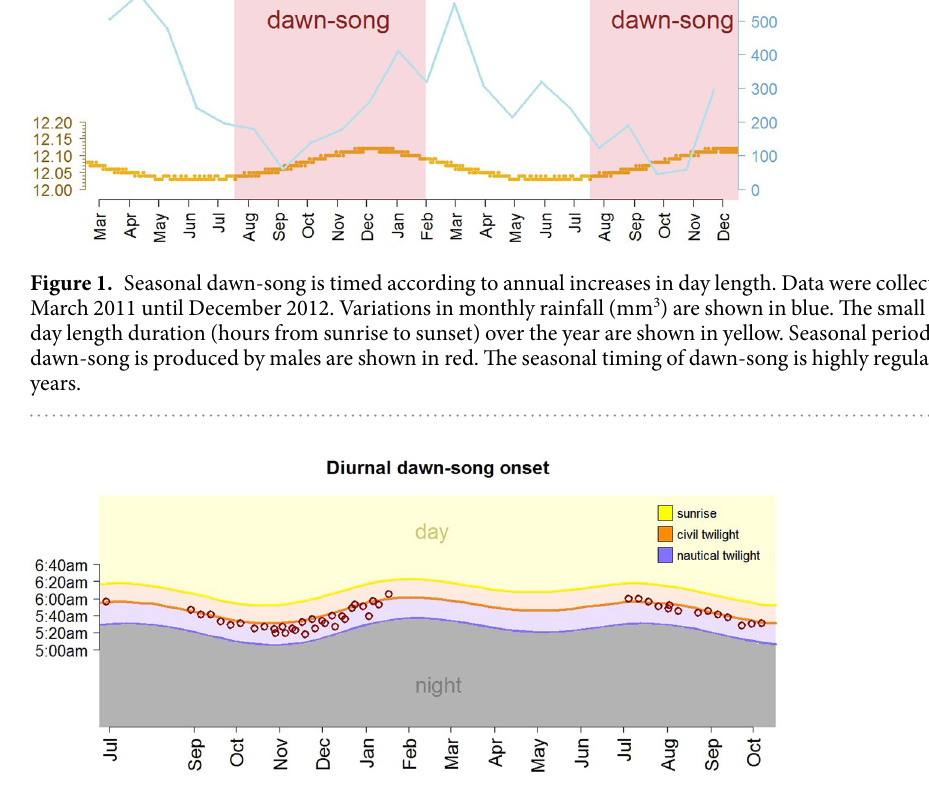
Figure 2. Onset time of dawn-song precisely follows variations in twilight time. The daily hour of the sunrise (yellow), the daily hour of the civil twilight (orange), and the daily hour of the nautical twilight (purple) are shown from July 2011 until October 2012. The red open circles represent the onset time of the first dawn-song occurred in the day. No recordings were available for August